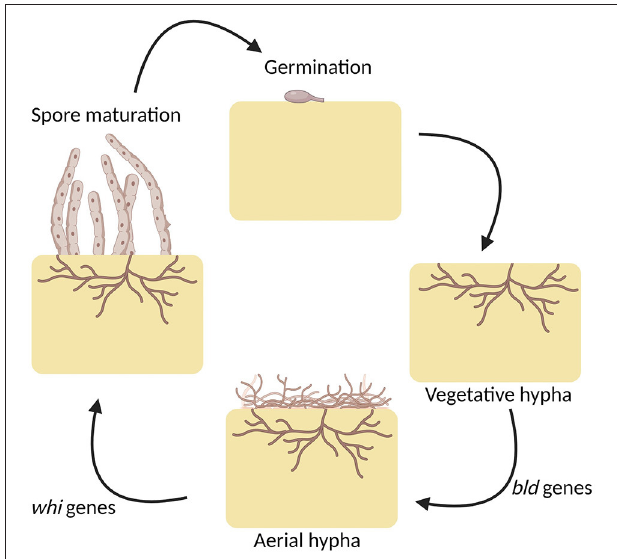
FIGURE 1 | The scheme of classic Streptomyces life cycle begins with spore